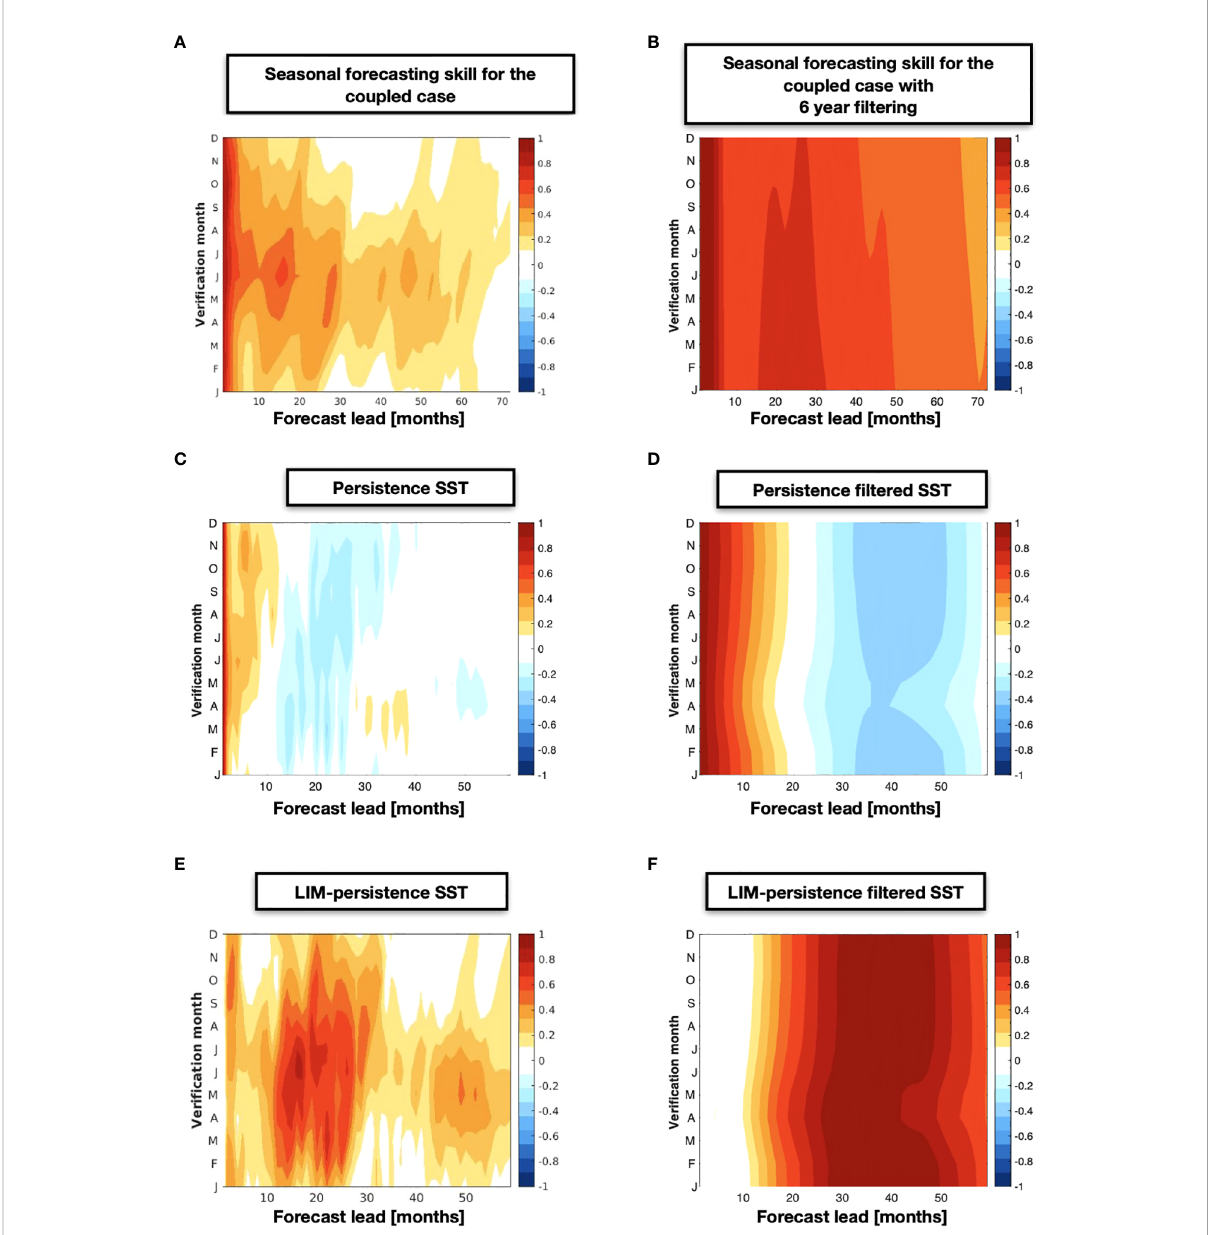
FIGURE 4 KOE SSTa index forecast correlation skill as a function of the initialization month of the year from the physics only LIM (A) , the persistence (B) , and their difference (C) . The same correlation skill maps are shown but computed after applying a 6-year low-pass fi lter applied on the original and forecasted monthly data (D , E) , and (F)